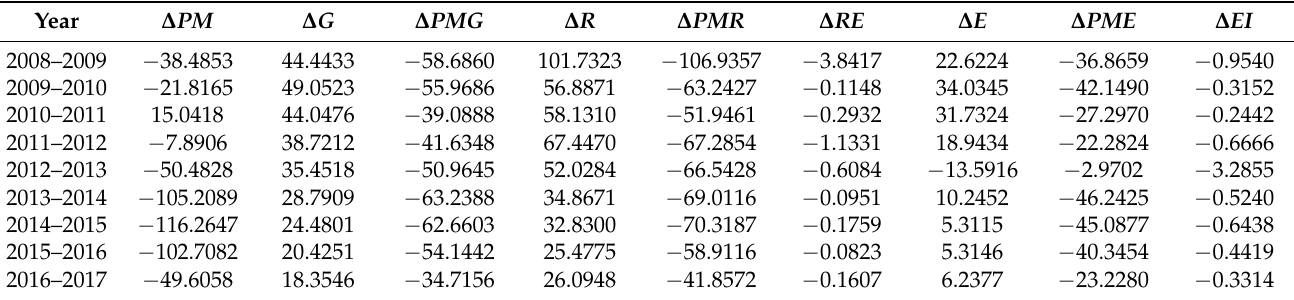
Table A1. Decomposition results in China from 2008 to 2017 (unit: 10 4 Mg).